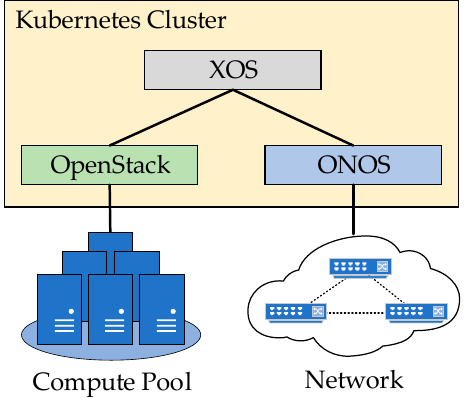
Figure 8. High-level overview of the CORD architecture.